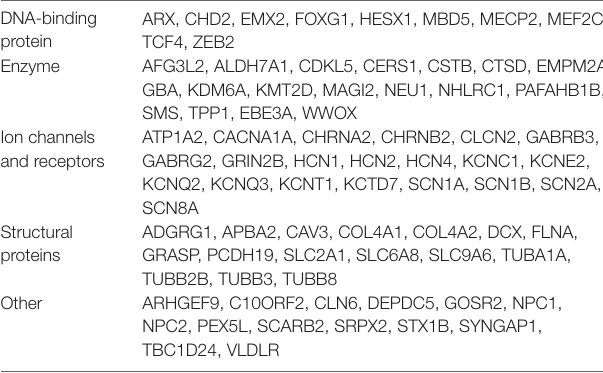
TABLE 1 | List of genes analyzed in the customized panel. DNA-binding